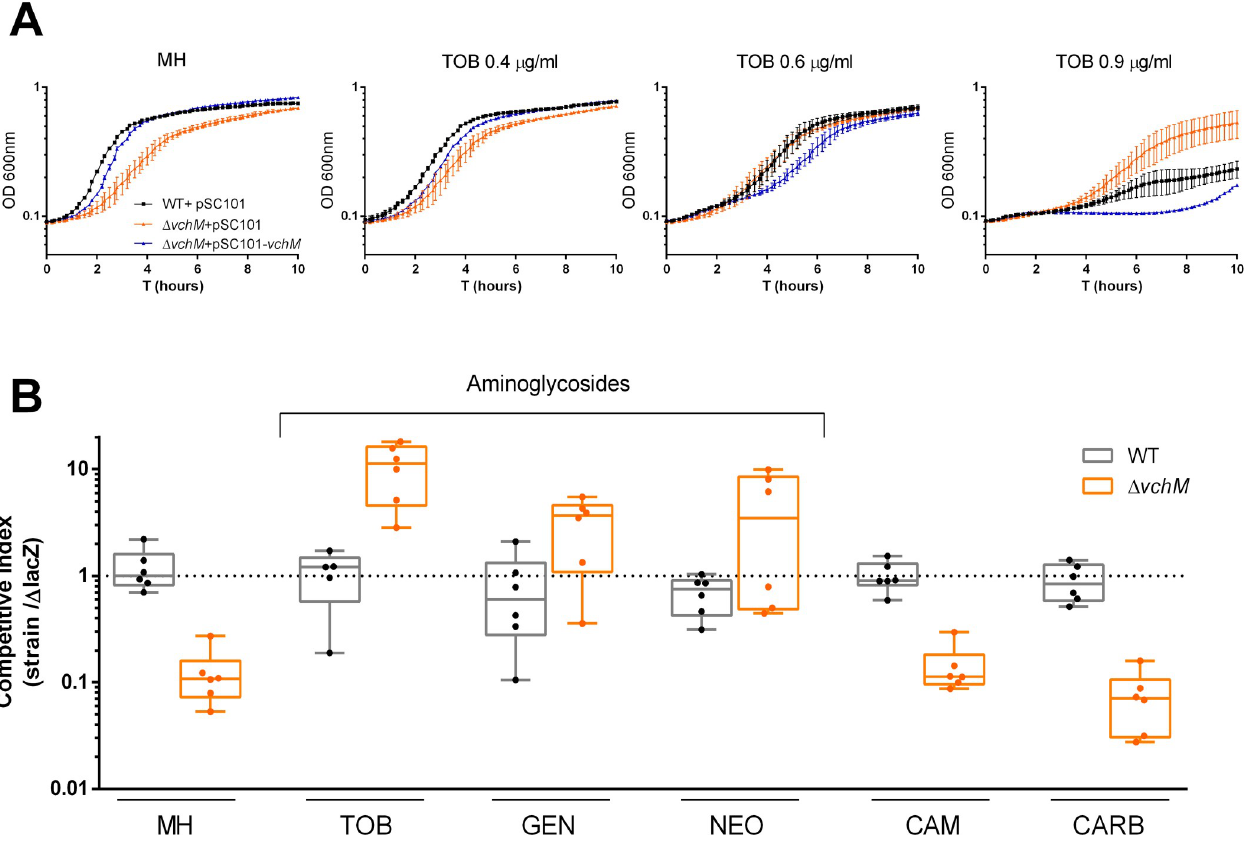
Fig 1. V . cholerae N16961 Δ vchM is less susceptible to subMIC aminoglycosides A. Growth curves in absence (MH) or presence of subMIC doses of tobramycin. Bars represent SD (n = 3) B. In vitro competitions of WT and mutant strains against isogenic Δ lacZ reference strain in absence or presence of different antibiotics at subMIC concentrations (TOB, 0.6 μ g/ml; GEN, 0.5 μ g/ml; NEO, 2.0 μ g/ml; CAM, 0.4 μ g/ml; CARB, 2.5 μ g/ml). Box plots indicate the median and the 25 th and 75 th percentiles; whiskers indicate the min and max values (n = 6).